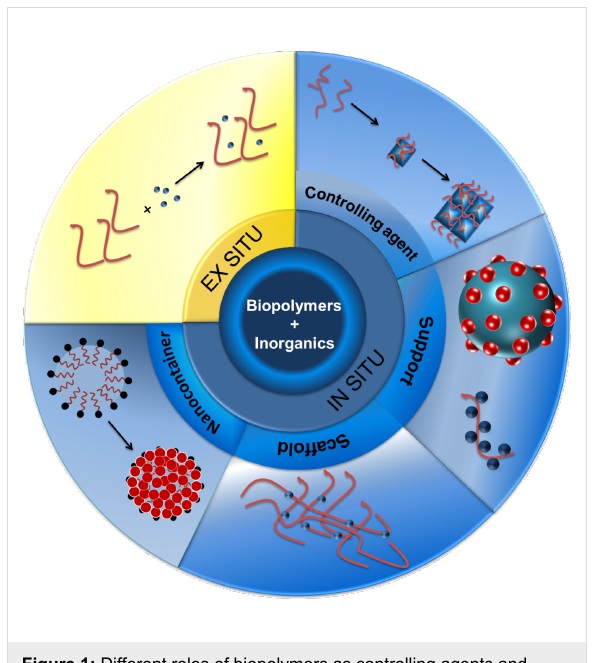
Figure 1: Different roles of biopolymers as controlling agents and templates in the formation of inorganic materials.